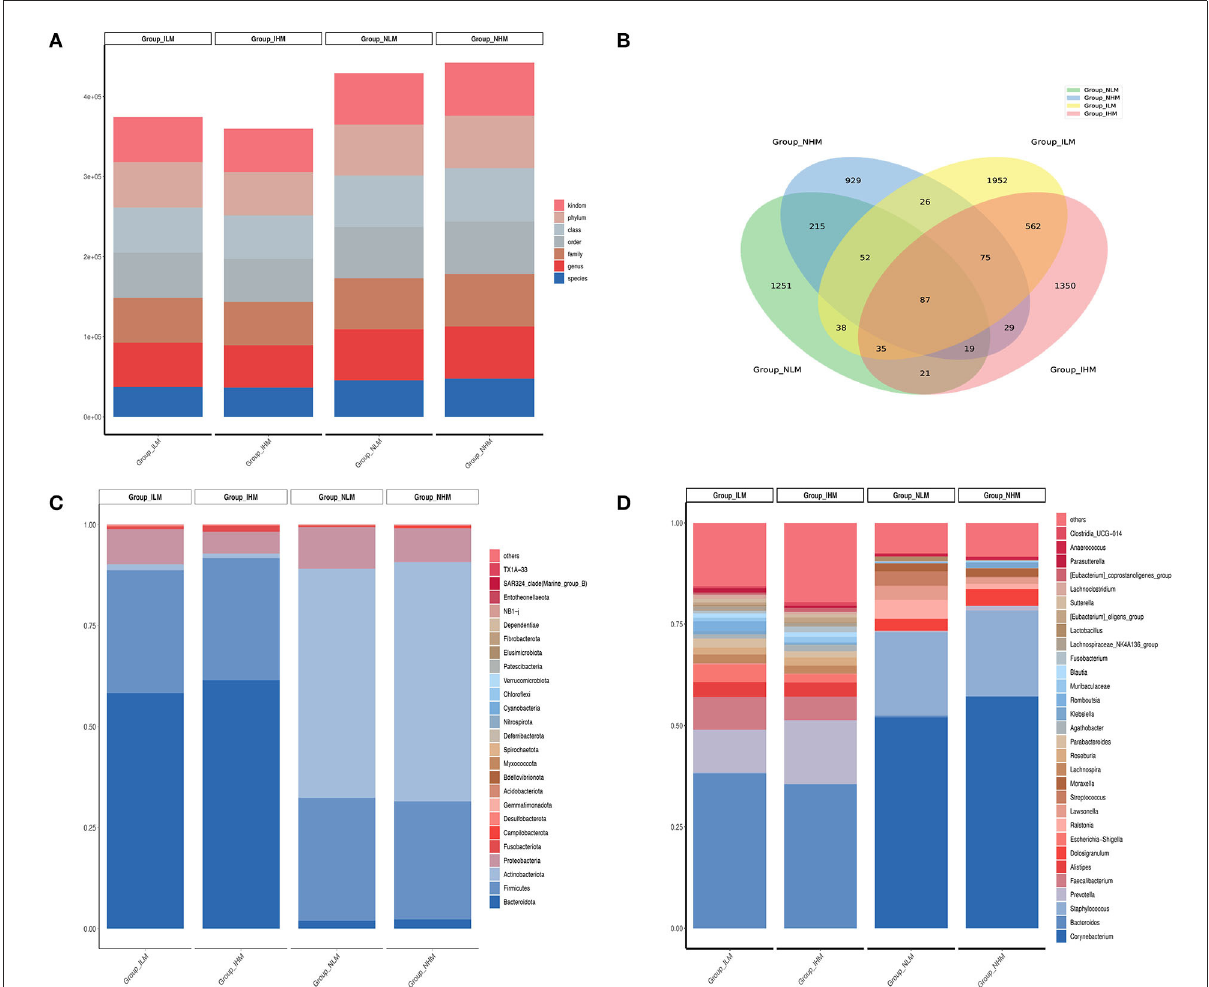
FIGURE2 Histogram of abundance-ranked. (A) The total amount of valid tags obtained from the four groups. (B) A Venn diagram. (C,D) The histogram of abundance-ranked top 30 microbes.